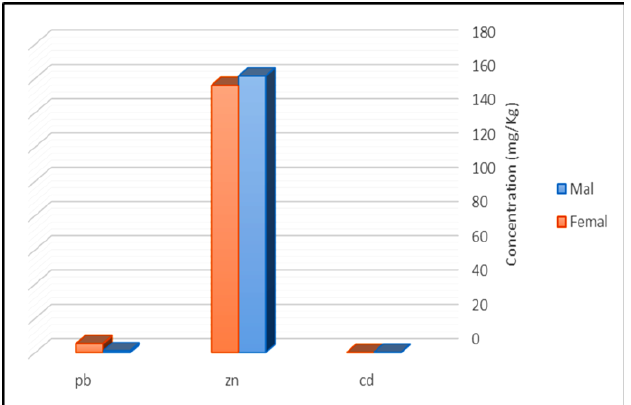
Figure 1: Average concentration of heavy metals in population sample.